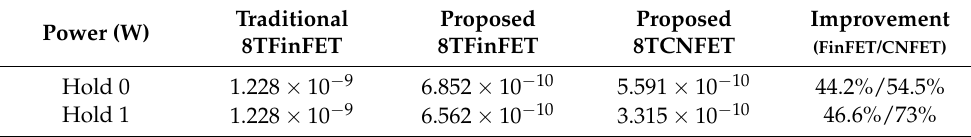
Table 5. Static power consumption comparison.